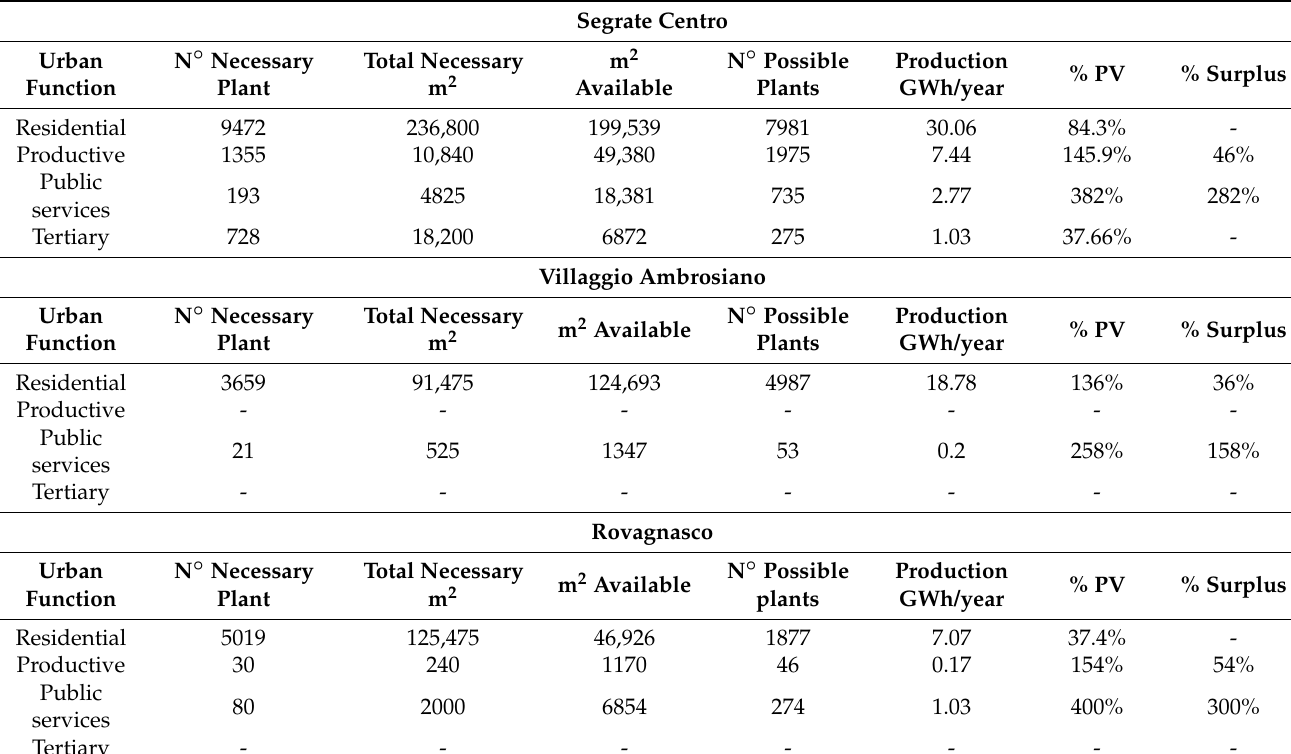
Table 7. PV plants necessary and PV plants really placeable in the case study’s neighborhoods after the low-temperature geothermal system introduction.